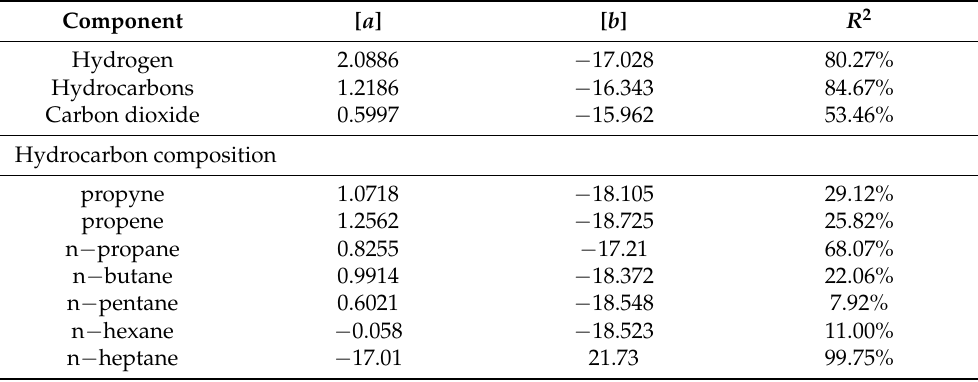
Table 8. Rate constant for the gases produced at 348 K. Ln k f = [ a ] Log [ P ] + [ b ], where [ a ] and [ b ] are regression constants. R 2 = coefficient of determination. n =